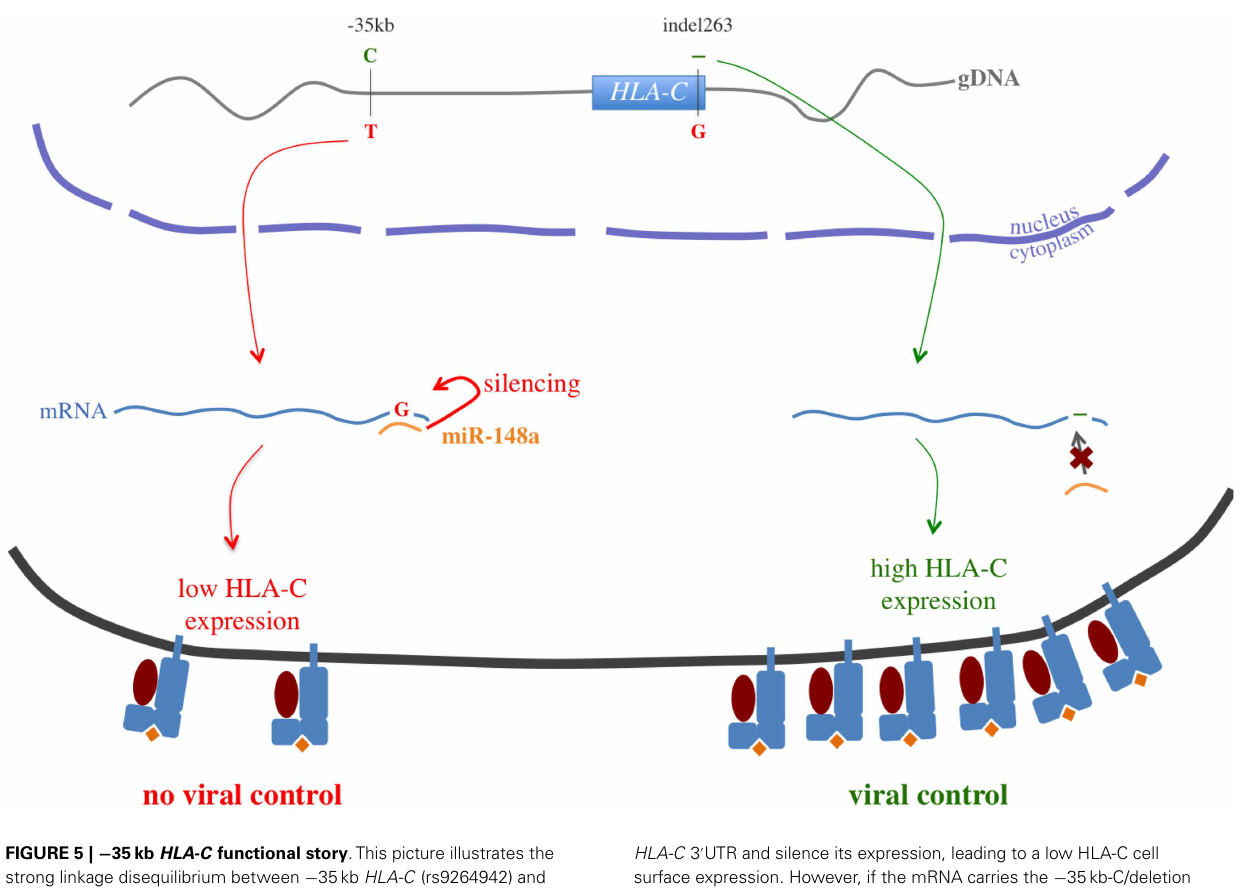
HLA-C 3 (cid:48) UTR and silence its expression, leading to a low HLA-C cell surface expression. However, if the mRNA carries the − 35kb-C/deletion haplotype, miR-148a cannot bind efficiently to the HLA-C 3 (cid:48) UTR anymore, and HLA-C cell surface expression is increased.This mechanism would mostly explain the association between the − 35kb HLA-C polymorphism and viral